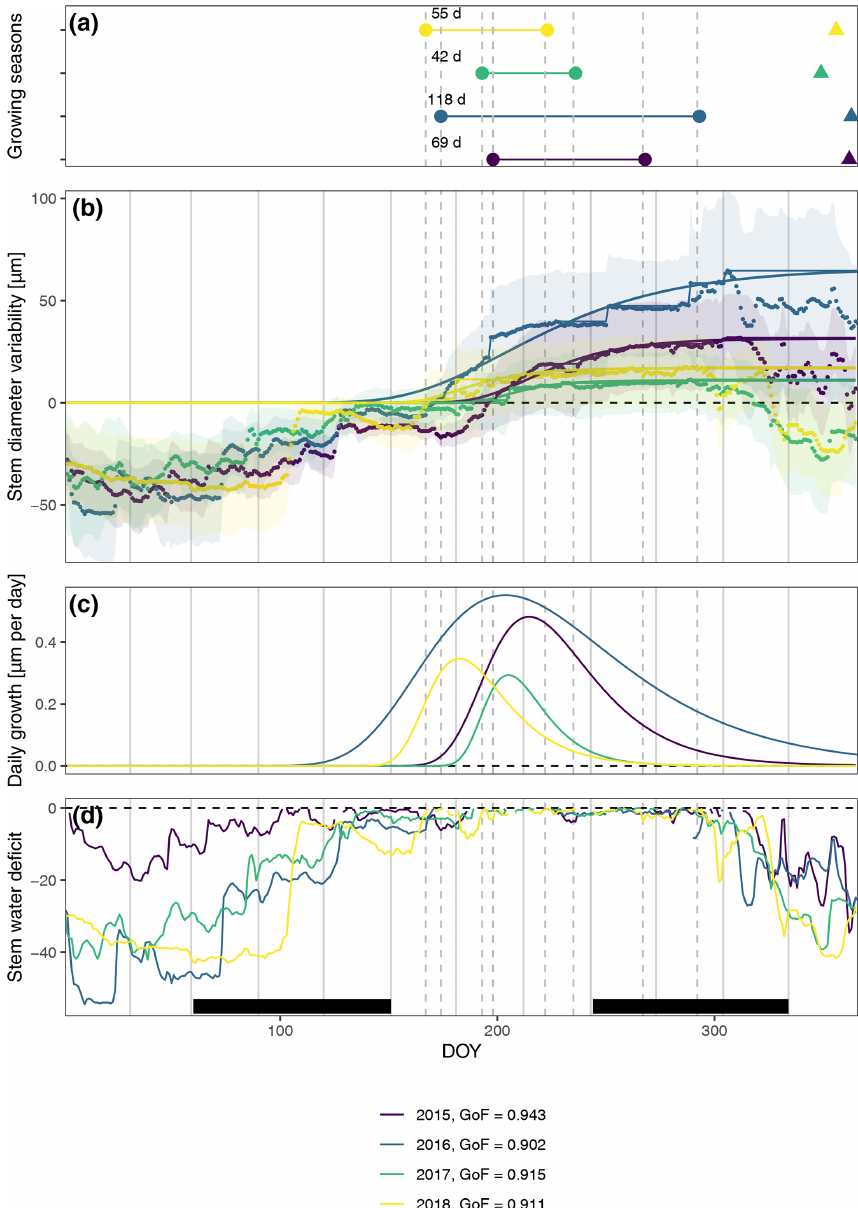
Figure 1. Observed and modeled variability in stem diameter. (a) Growing seasons derived from fitted Gompertz models and timing of peak shrinking defined as the maximum stem water deficit (triangles). (b) Averaged measured daily stem diameter variability and fitted Gompertz models (a goodness-of-fit (GoF) measure was calculated using the least-squares method). Models were fitted to zero growth curves derived from the original measurements as cumulative maxima (thin lines), assuming zero growth during phases of prolonged stem shrinkage. In this way, annual growth and, consequently, growth start are directly linked to growth during the previous year, and additional rehydrating processes before the start of the main growing season are excluded. Shaded areas indicate standard deviation, showing the variability among the specimens. (c) Daily growth rates derived from Gompertz models. (d) Stem water deficit defined as reversible radial stem variability at times when no growth-induced irreversible stem expansion was measured. Black bars indicate meteorological seasons, while dashed lines show timing of the respective growing seasons to aid visual